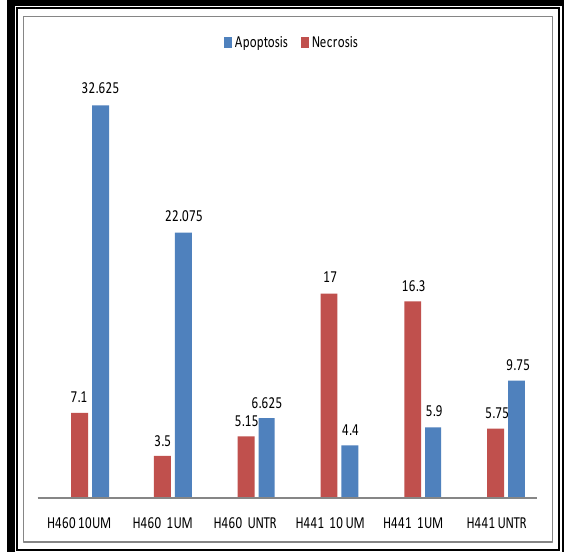
Figure 5 : Apoptosis and necrosis after 24 hr of nicotine treatment with concentration (1 μM) in H460 lung cancer cells by flow cytometry.